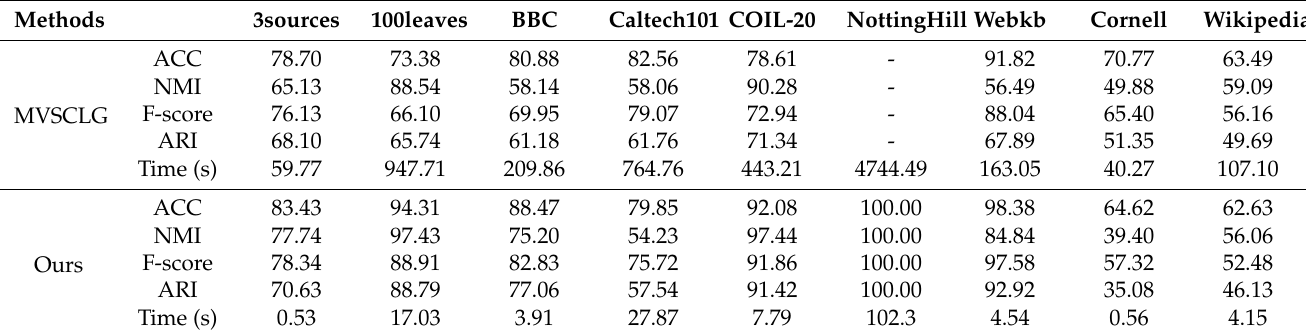
Table 7. Comparing LGOMSC with MVSCLG on nine multi-view data sets.